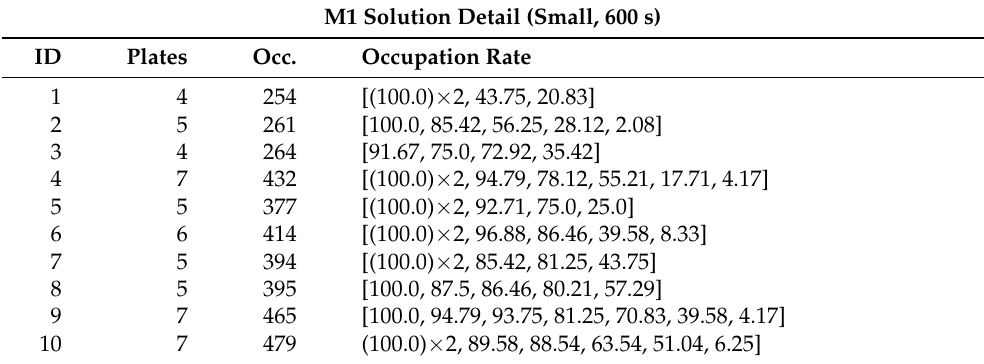
Table A11. M1 solutions detailed for small files, limited to 600s.